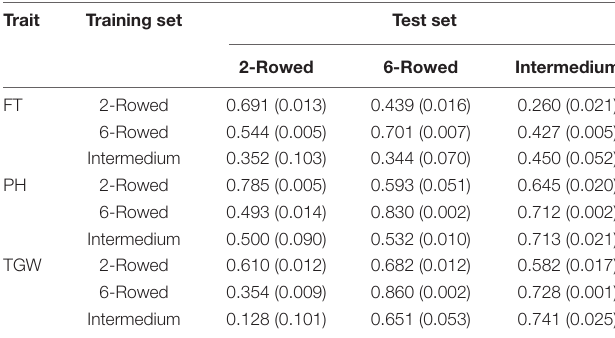
TABLE 1 | Genome-wide prediction abilities within and across row type subpopulations for the winter barley accessions phenotyped for flowering time (FT), plant height (PH), and thousand grain weight (TGW).